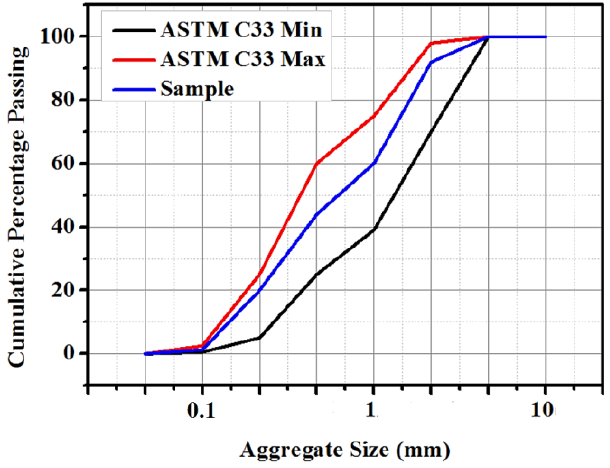
Figure 3. Particle size analysis of the fine aggregates.